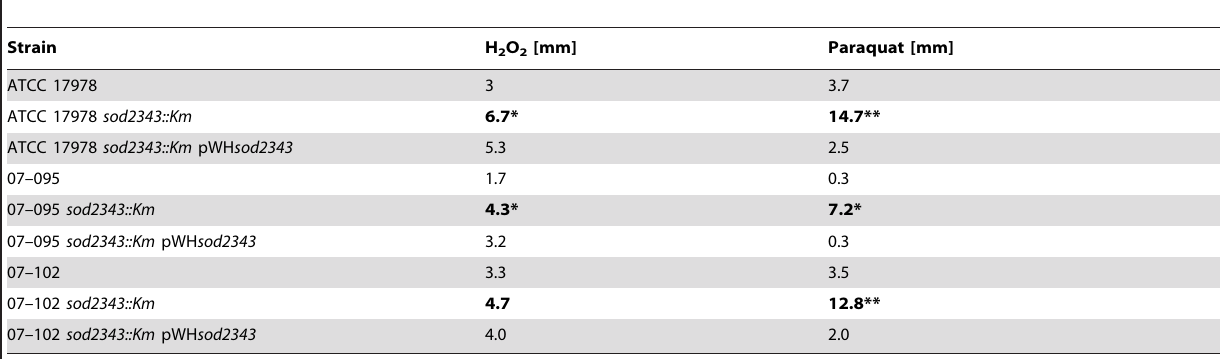
Average dimension of inhibition zone determined as the distance between paper disc and the front line of growth [mm], determined from three independent experiments. 5 m l of 10% H 2 O 2 and 5 m l of 5 mg/ml paraquat, respectively, was deposited on a paper disc with a diameter of 5 mm; values given in bold indicate a significant difference between a given mutant and its corresponding parental strain (p , 0.005; Student’s t-test, two-tailed, unpaired; * indicates p , 0.0005; ** indicates p , 0.00001).